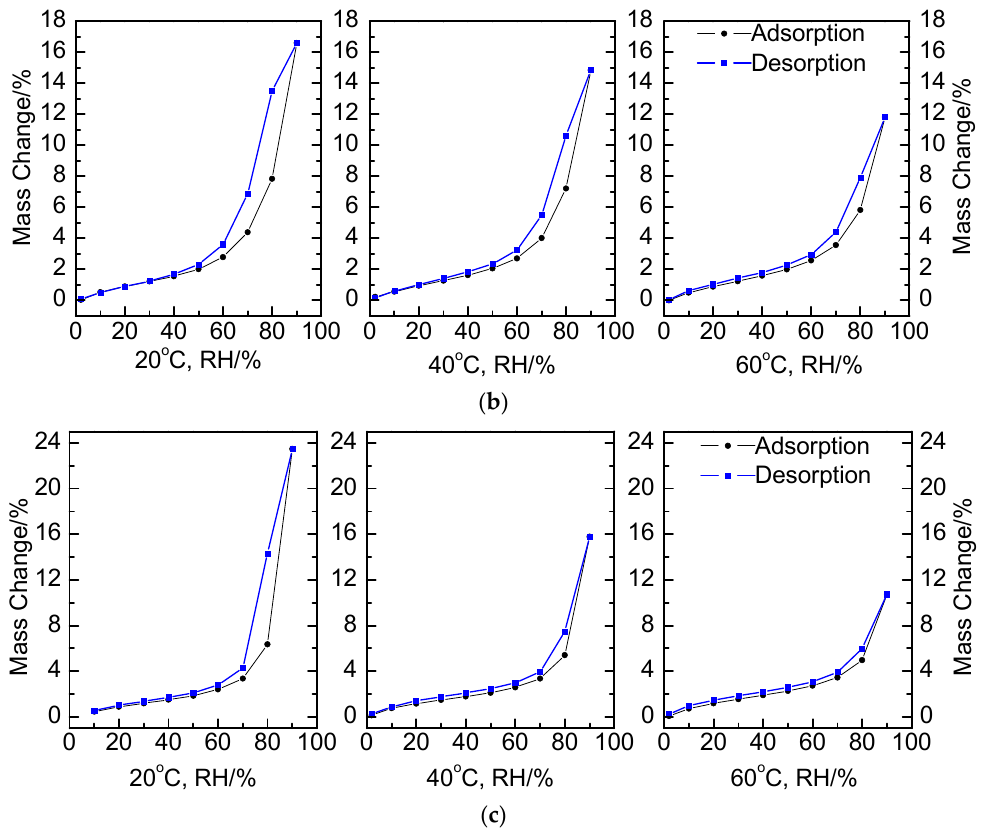
Figure 3. Water vapor adsorption/desorption isotherms on SGA (smelter grade alumina) at 20 °C, 40 °C, and 60 °C. ( a ) sample #1, ( b ) sample #2, ( c ) sample #3.